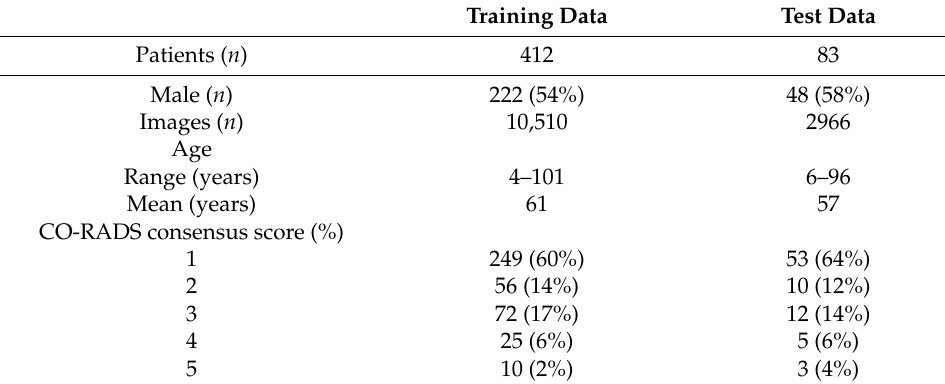
Table 2. Summary of training and test datasets.